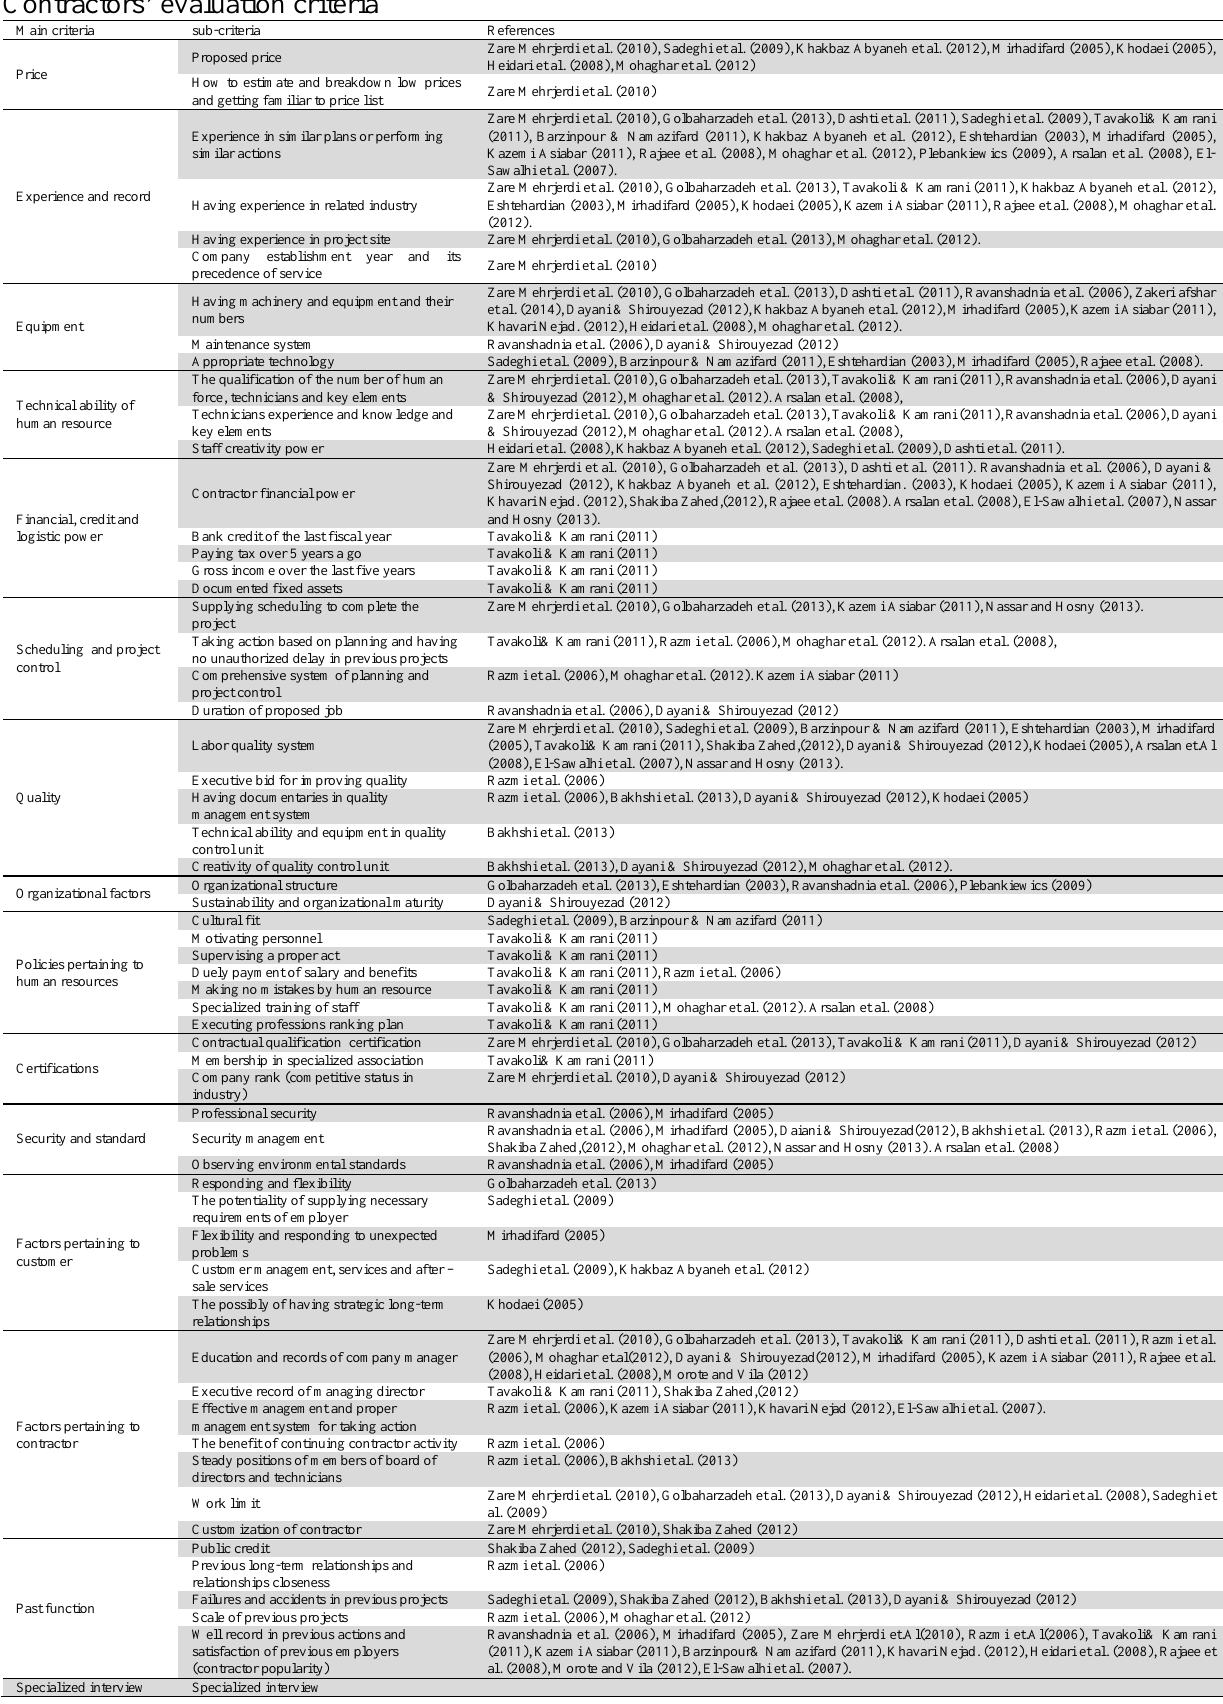
Contractors’ evaluation criteria Main criteria